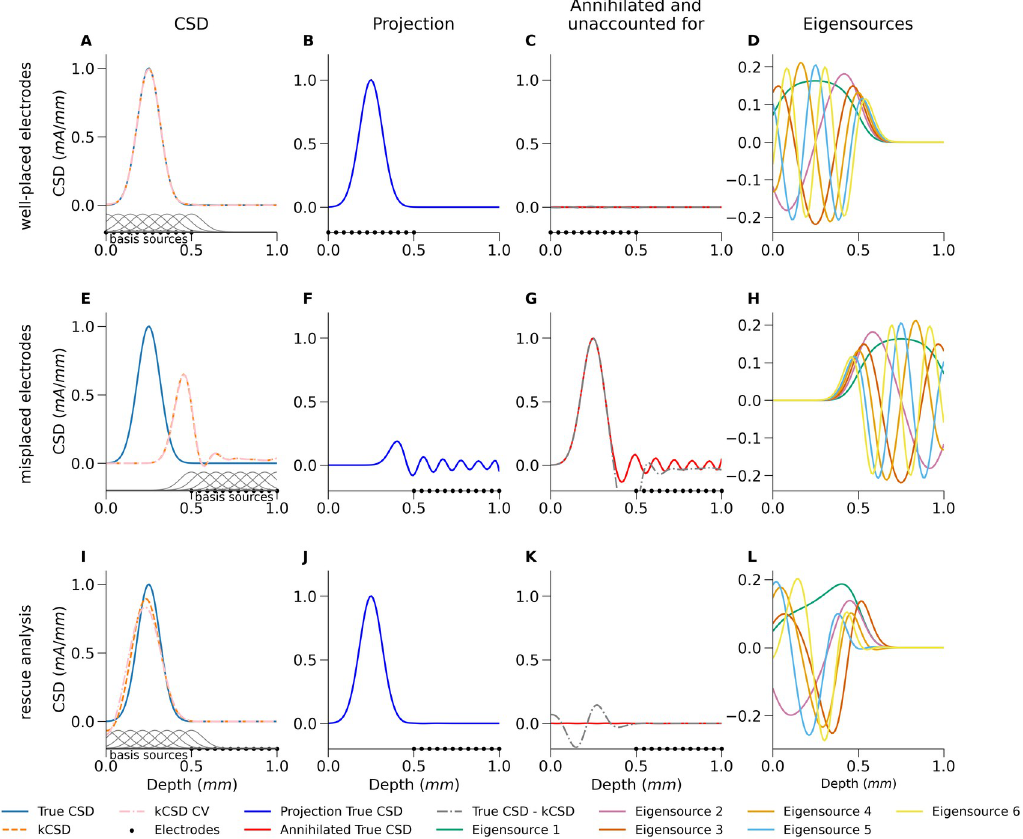
Fig 1. Proper placement of basis sources allows analysis of data collected with misplaced electrodes. Demonstration of kCSD reconstruction for different relative placement of basis sources and electrodes for simple 1D Gaussian source in the absence of noise. Width of the basis source, R , was selected through cross-validation for the first case (A) and used throughout. Left column shows the true source (continuous line) and the kCSD reconstruction (broken line) as well as the location of the electrodes where the potential was “measured” (dots on the horizontal axes) and the positions of the basis sources (gray Gaussians on lower axis, first column). Second column: projections of the true source on the space of eigensources, the part of the true source accessible to the kCSD method. Third column: the part of the true source which is annihilated or not accessible experimentally and the difference between the True CSD and the reconstruction (broken line). Fourth column: the eigensources for the given setup. First row: the electrodes and the basis sources are placed in the region containing the source to be reconstructed ([0, 0.5]). Second row: the electrodes were badly misplaced ([0.5, 1]) and the basis sources placed where the electrodes are (standard CSD analysis). Third row: the electrodes were badly misplaced ([0.5, 1]), to compensate during analysis the basis sources were placed where the source was expected, ([0, 0.5]). kCSD – λ =0; kCSD CV – λ selected through cross-validation.